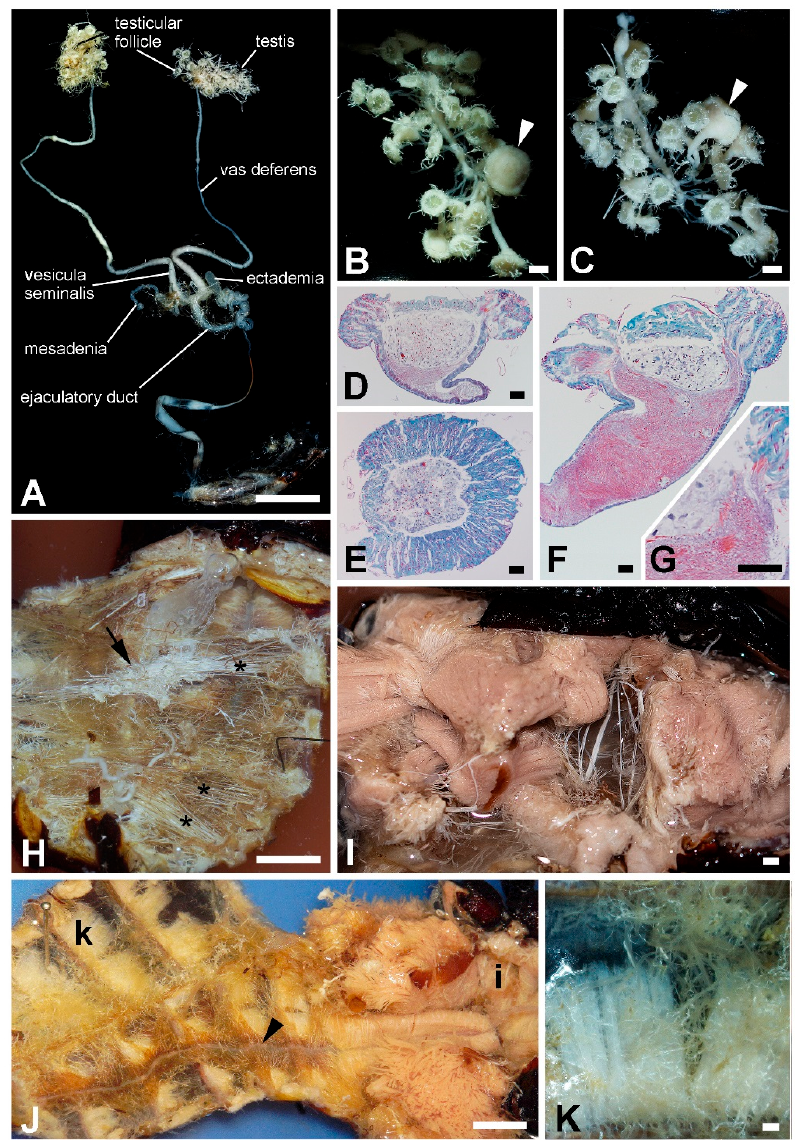
Figure 5. T. giganteus , internal morphology. ( A )—Male reproductive system. ( B , C )—Detailed images of testis. Arrowheads depict one testicular follicle that is larger than all others are. ( D , E )—Mallory staining of longitudinal- and cross-section, respectively, through small testicular follicle. ( F )—Mallory staining of longitudinal-section of large testicular follicle with large number of sperm (in red). ( G )—The detailed view on the sperm clusters (red). ( H )—The open abdomen with bundles of trachea (stars) and testes (arrow). ( I )—Flight muscles in the thorax. ( J )—Muscles in the abdomen and thorax. Lower-case letter show areas of detailed images (I) and ( K ). The dorsal aorta is marked by arrowhead. ( K )—Detailed image of muscle bundle under the cuticle on ventral thorax. Scale bar: 1 cm ( A , H , J ); 1 mm ( B , C , I , K ); 100 μ m ( D – G ).